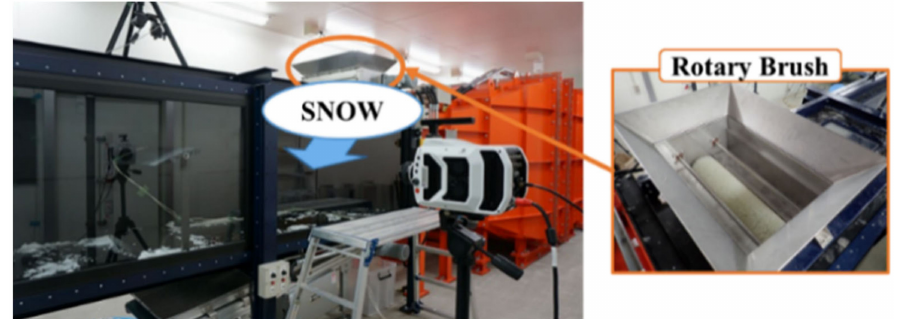
Figure 4. Natural-snow wind tunnel.